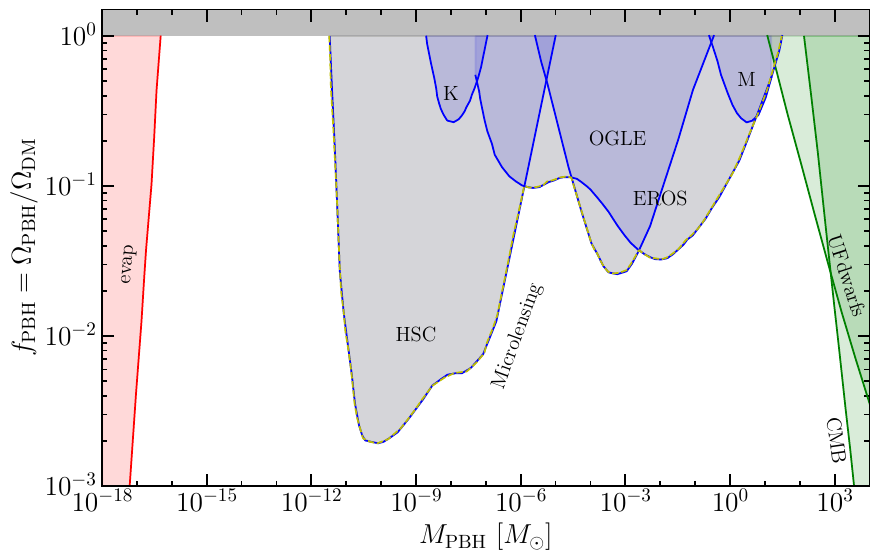
Figure 1. Examples of bounds on the abundance of PBH are plotted using [119]. ‘evap’ signifies bounds from PBH evaporation [129] via Hawking radiation; HSC [102], Kepler (K) [130], EROS [101]. MACHO [131] and OGLE [103] signify the bounds from microlensing (yellow dashed line enveloping the blue and grey shaded regions); ‘UFdwarfs’ signifies bounds from ultra-faint dwarf galaxies [132]; ‘CMB’ signifies bounds from Compton drag and Compton cooling of CMB photons